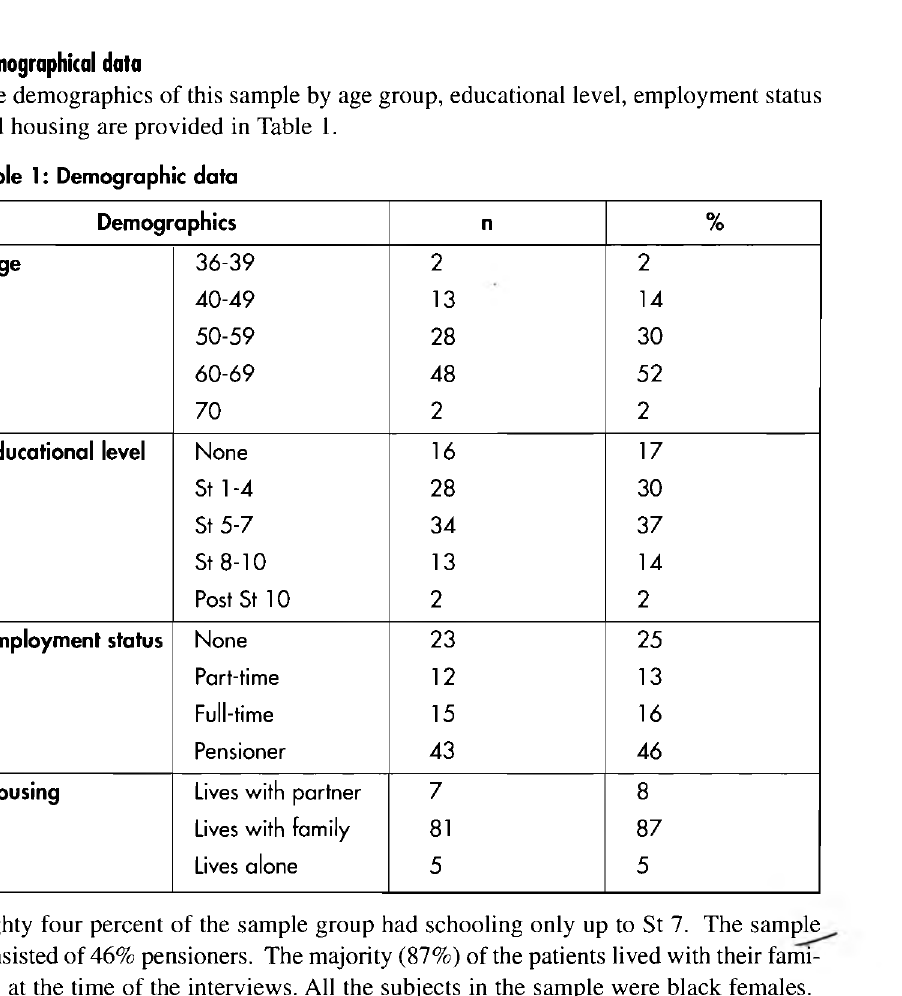
Table 1: Demographic data